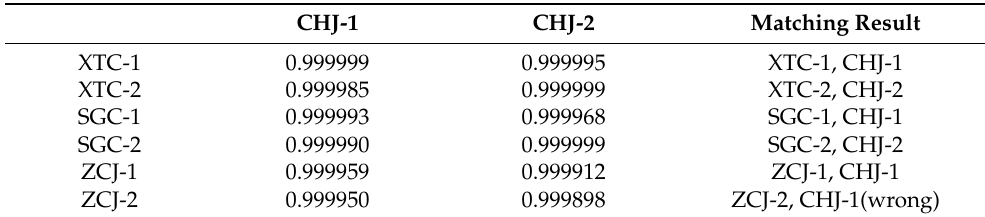
Table 3. Correlation coefficients and matching results between the pulse multiple features of the CHJ station and the other three stations.